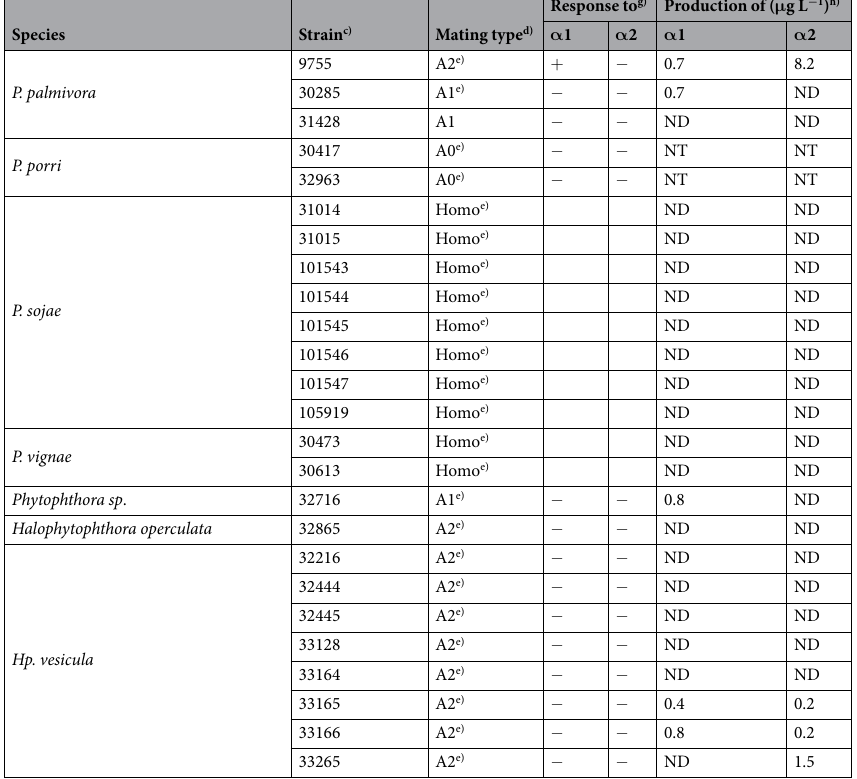
Table 1. Response to and production of mating hormones in the genera Phytophthora and Halophytophthora . a) Variants (var. nicotianae , var. parasitica ), which are regarded as synonyms in the NBRC catalog, are omitted (see supplementary Table S1 for details). b) Species to be revised on the basis of a recent ribosomal RNA gene analysis by NBRC. c) Numerals indicate NBRC numbers (for instance, 30474 represents NBRC 30474). d) Assigned by a co-culture method with the standard strains P. nicotianae ATCC 38606 (A2) and 38607 (A1) (Fig. 2, Table S1). Homo and A0 indicate homothallic (self-fertile) and neuter strains, respectively. e,f) These mating types are newly assigned (e) or revised (f) by the present study. g) The “ + ” sign indicates a positive response (oospore formation) to a hormone, whereas the “ − ” indicates no response at the dose of 300 ng per disk. The hormonal response was not tested for the homothallic and A0 strains, which produce oospores without mating hormones and show no response, respectively. h) The sign ND (not detected) indicates